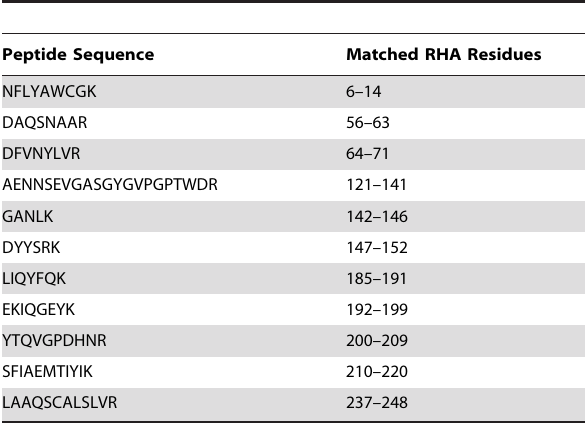
Table 1. Mass spectrophotometry sequencing of the PKR- associated protein